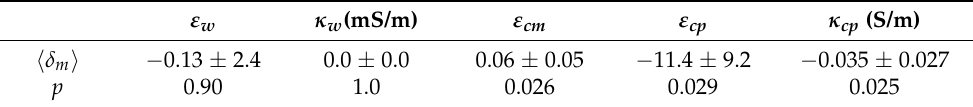
Table 1. Average difference between electrical phase parameters, plus or minus one standard deviation (n = 6 experiments), along with the p -value obtained by applying a paired Student’s t -test to pairs of Ste2-expressing cell suspensions, one with and one without α -factor added to it. ε w κ w (mS/m) ε cm ε cp